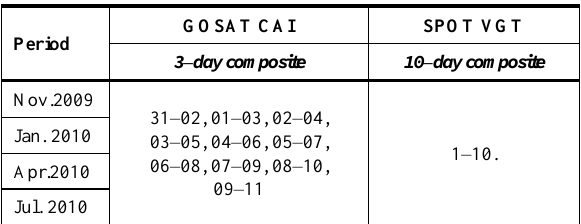
Table 2. Data used from two sensors in each